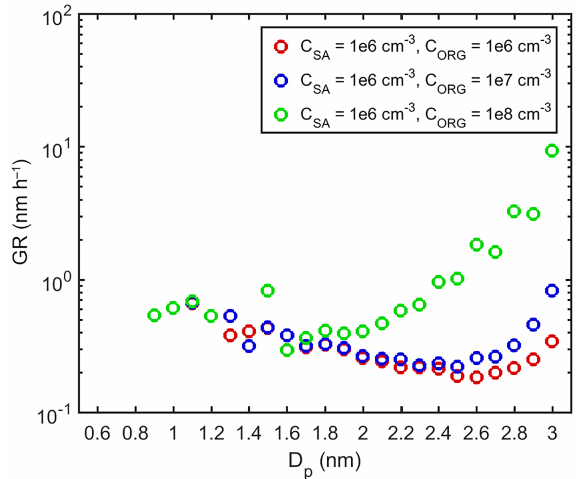
Figure A6. GRs determined for different size bins in simulations with SA–DMA and an organic compound with p sat = 10 − 8 Pa and m = 600amu (LVOC large ). The colors indicate vapor concentra- tions in each